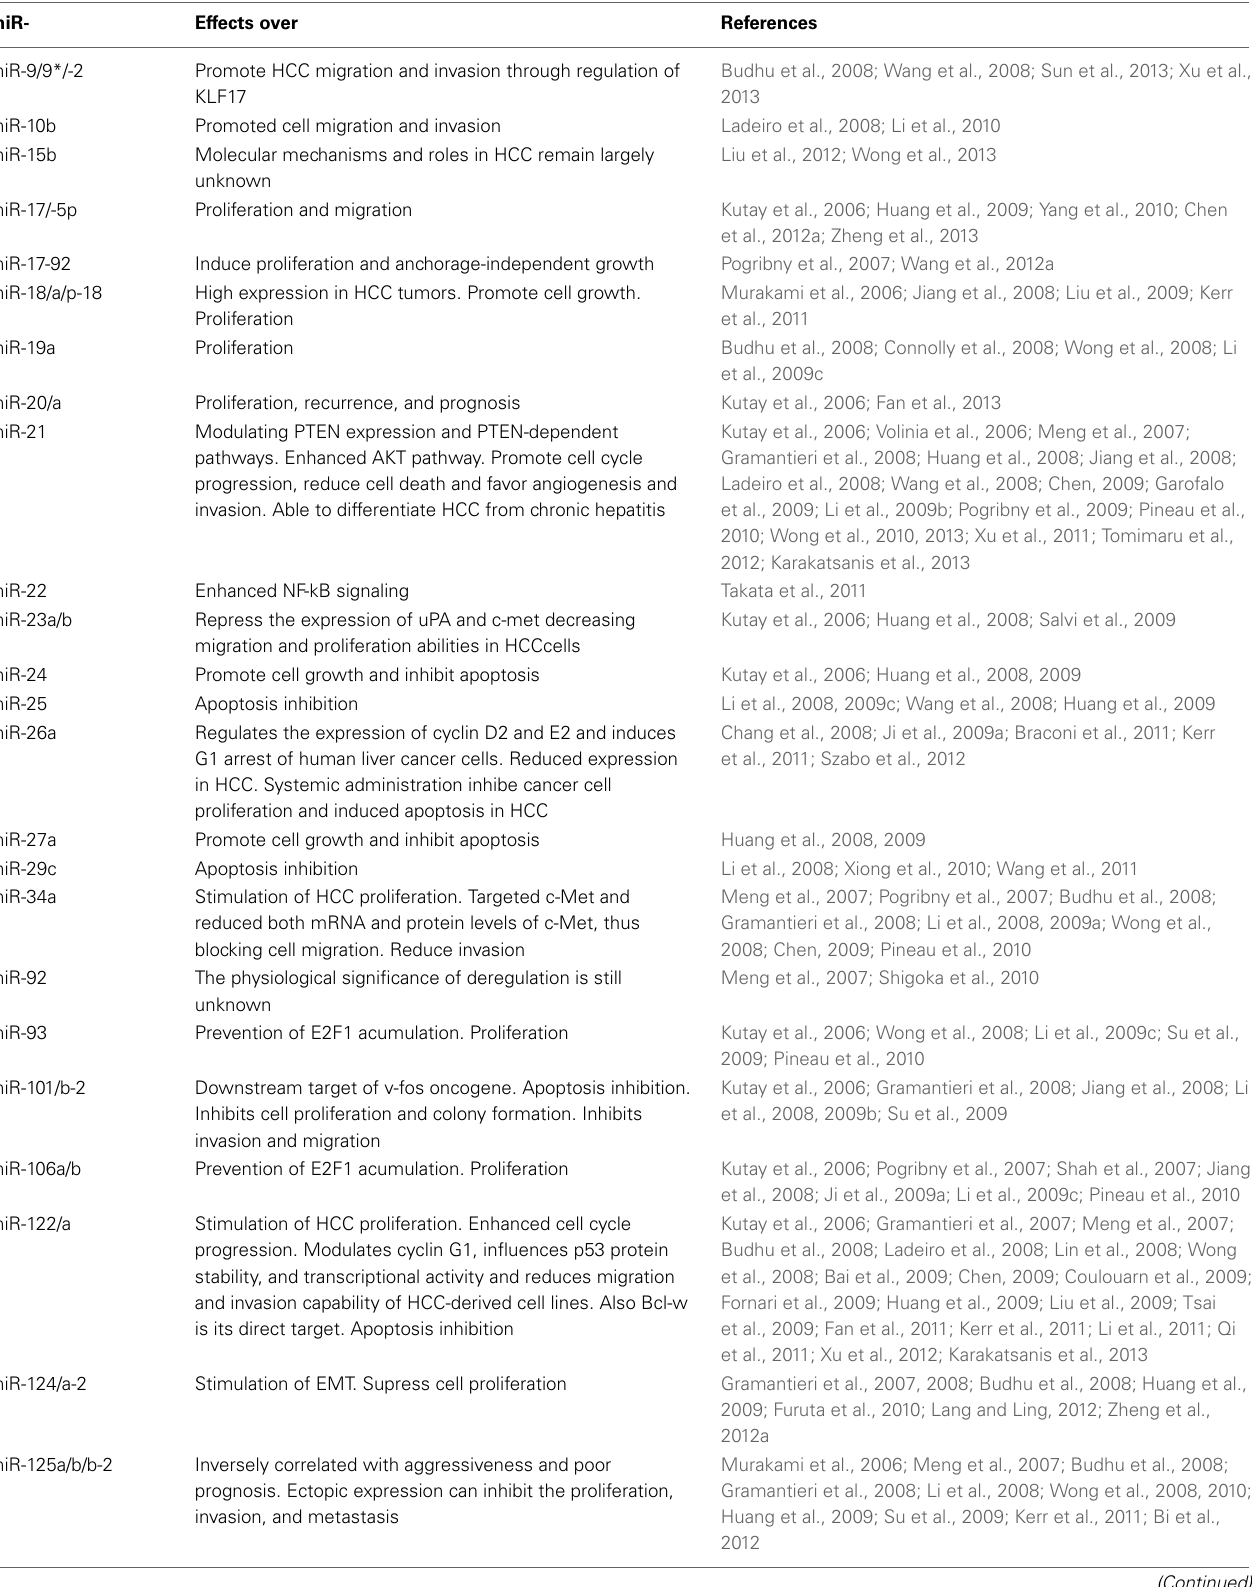
Table 1 | microRNA deregulated in